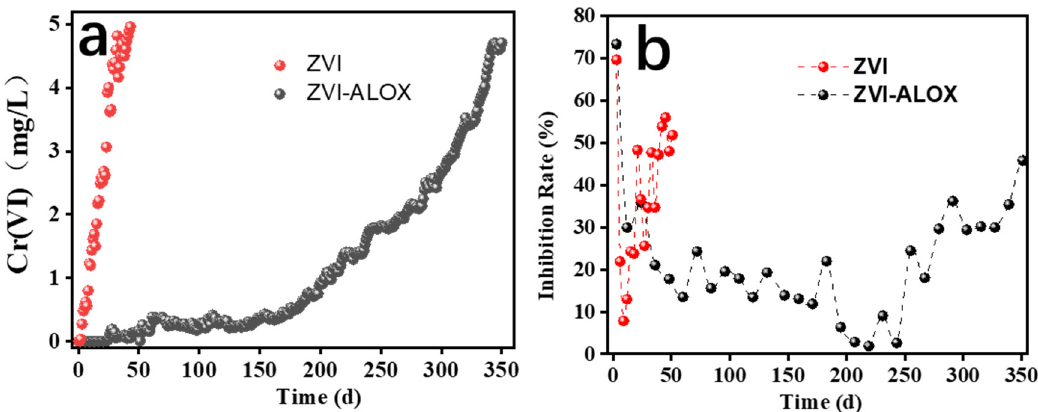
Figure 4. Long term removal experiments using ZVI and ZVI-ALOX (influent [Cr(VI)], 5 mg/L): ( a ) effluent concentrations of Cr(VI); ( b ) inhibition rates of P. phosphoreum in the column effluents.